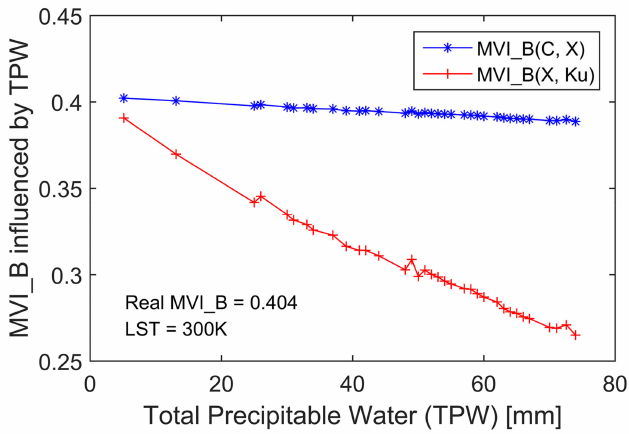
Figure 1. The effect of water vapor on MVI_B parameters.